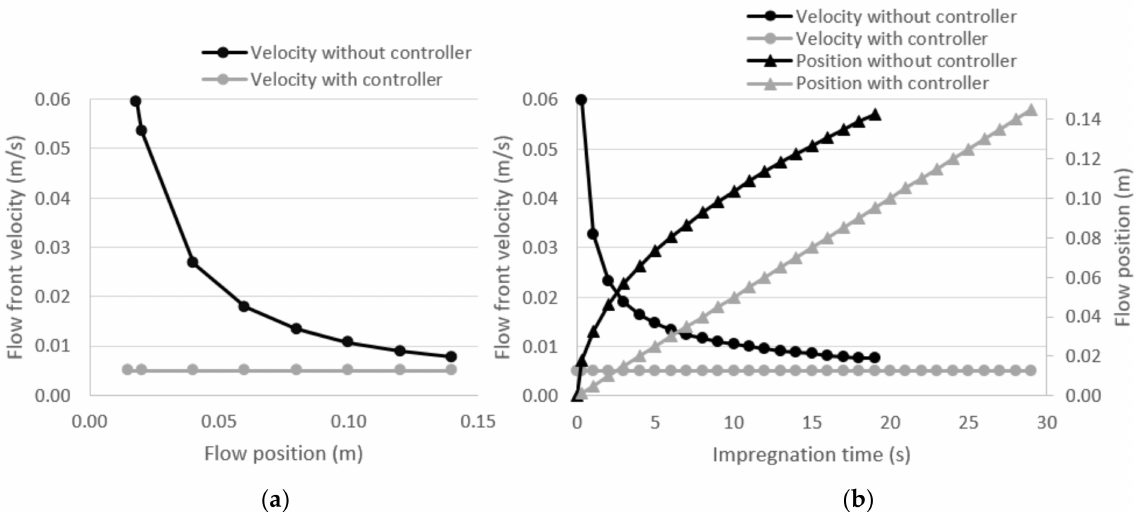
Figure 1. ( a ) Theoretical evolution of the flow front velocity as a function of flow position and the effect of adding the flow front controller; and ( b ) the theoretical evolution of the flow front velocity and position as a function of the process time and the effect of adding the flow front